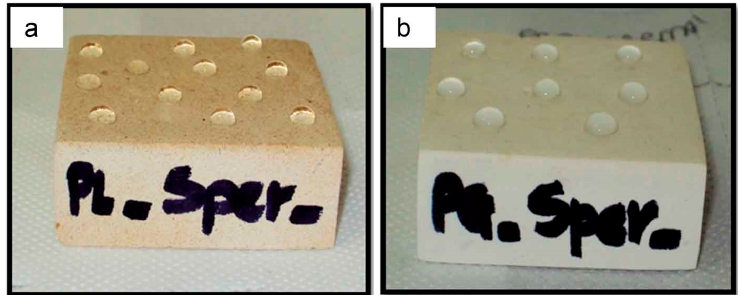
Figure 5. Measurements of contact angle performed on ( a ) Leccese stone and ( b ) Gentile stone specimens, both treated with Boehmite-based nano-composite coating. Reprinted with permission from [32]. Copyright 2017 Elsevier.